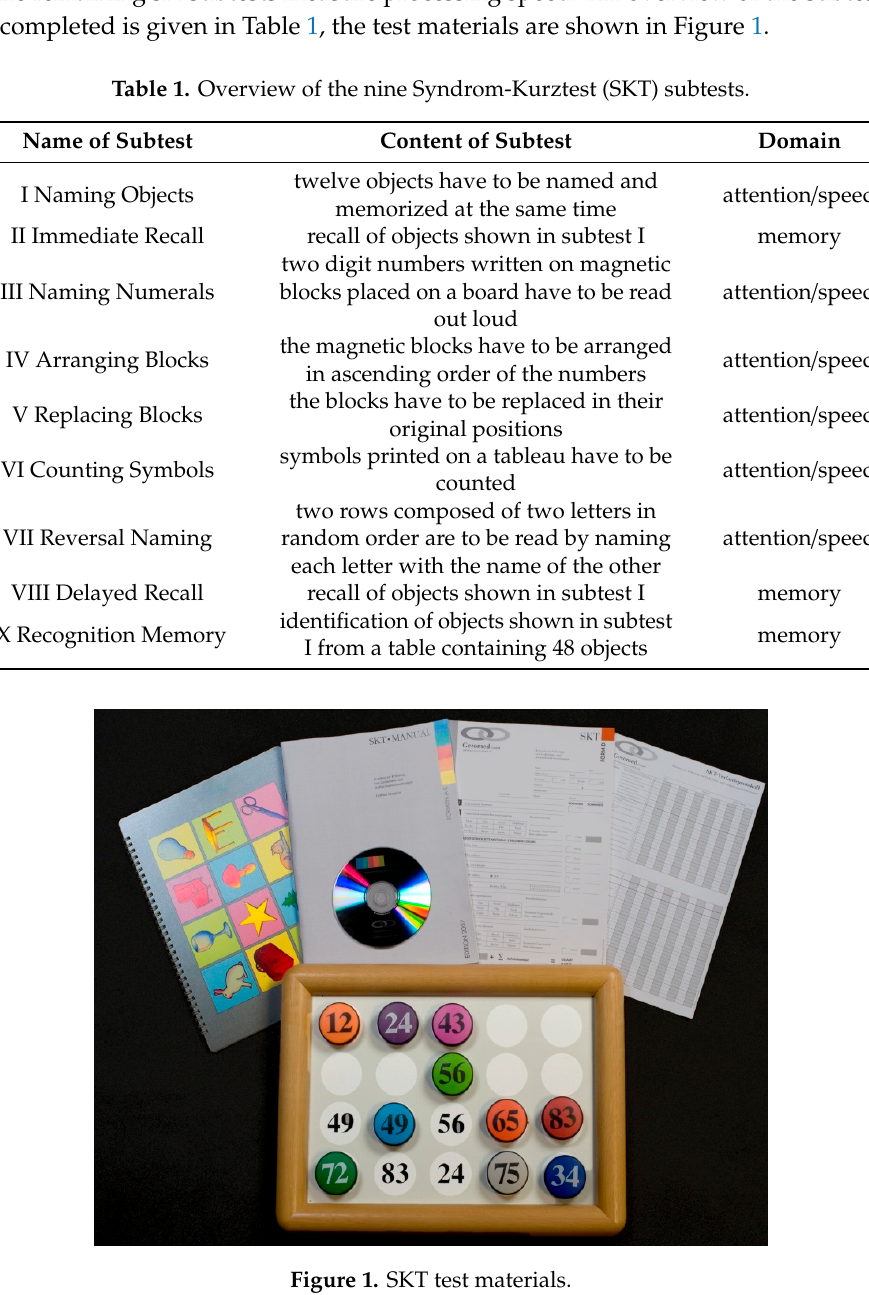
Figure 1. SKT test Figure 1. SKT test materials.